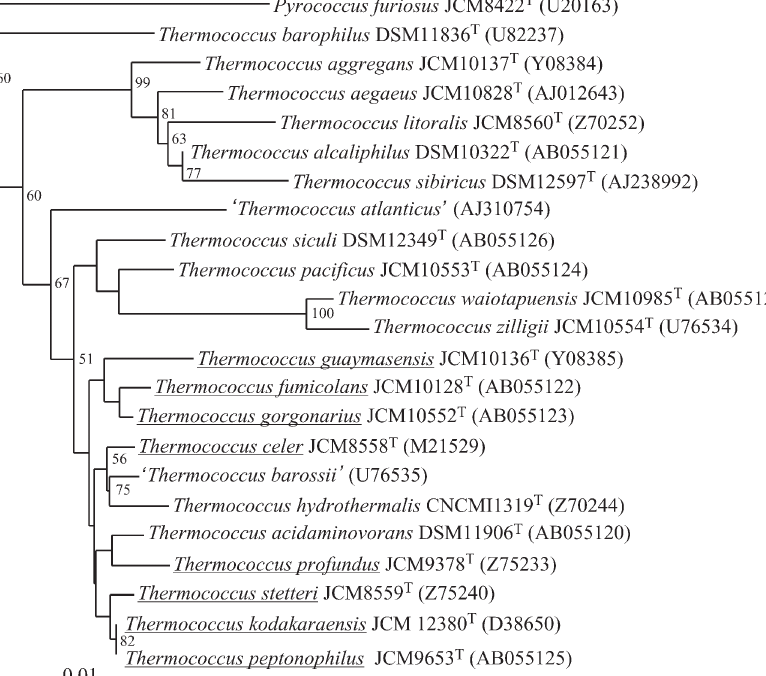
Figure 1. Phylogenetic tree showing the position of strain KOD1. The tree was constructed using the neighbor- joining method as described in the Ma- terials and methods. The scale bar rep - resents the expected number of changes per sequence position. Boot- strap values greater than 50% are shown in the tree. Strains used in DNA–DNA hybridization tests are un- derlined. Strains and accession num- bers for all sequences are